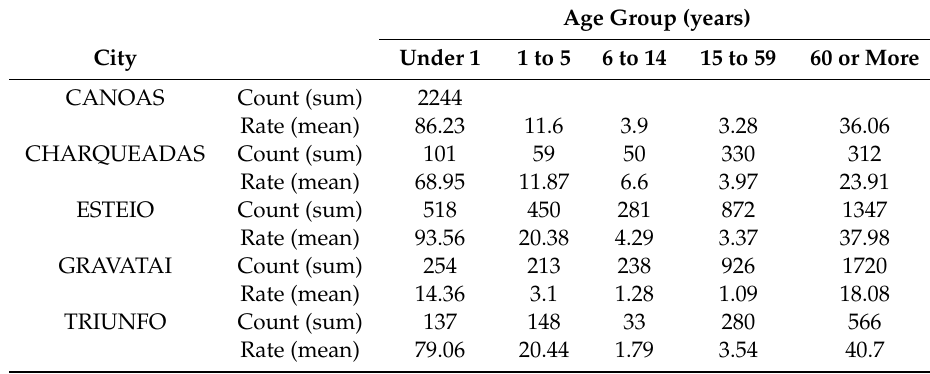
Table 2. Total counts and mean of monthly rates of hospitalizations per 100,000 inhabitants by age group and municipality, Rio Grande do Sul State, Brazil 2013–2016.